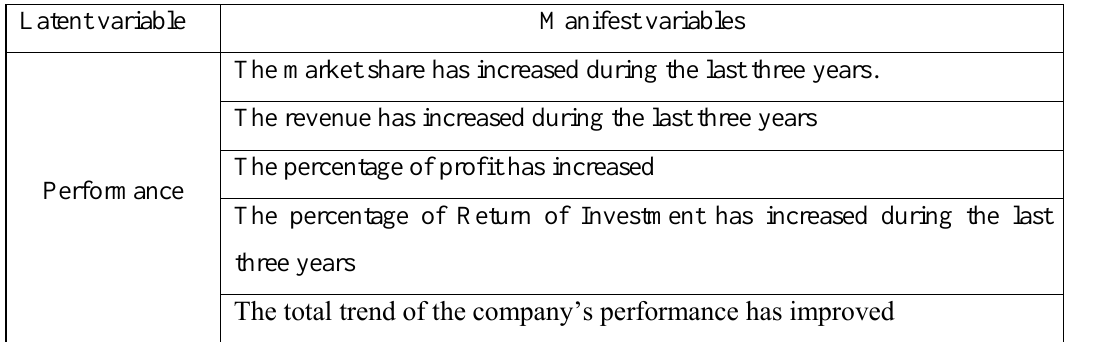
Table 2: Indicators of Performance Latent